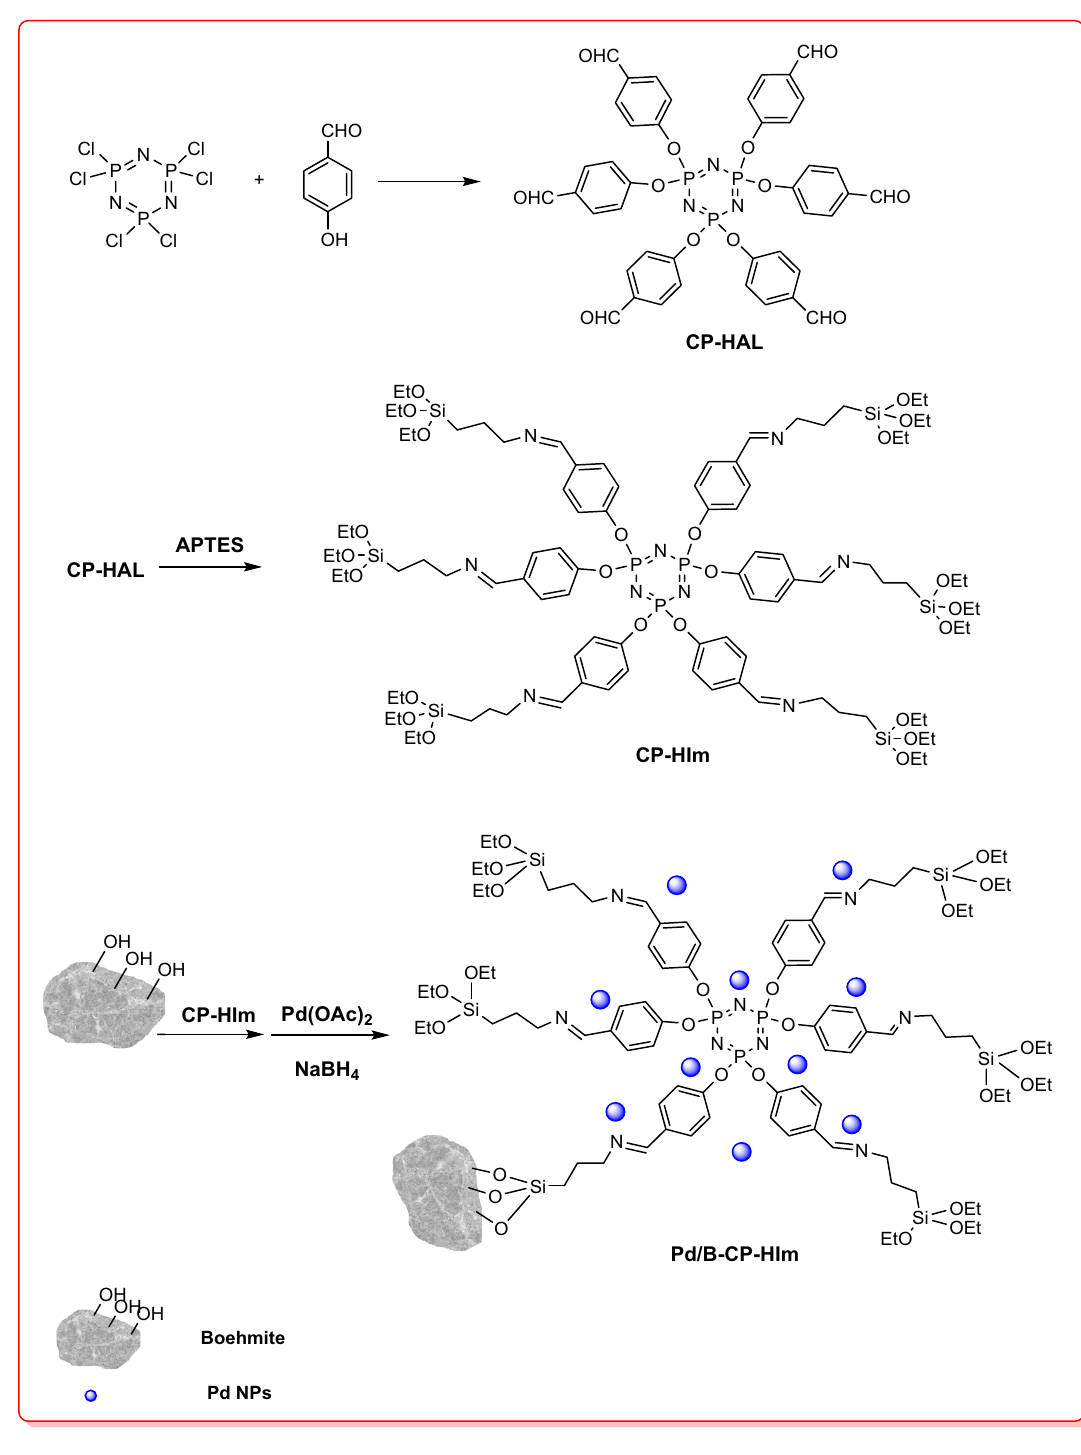
Figure 1. Pictorial procedure for the synthesis of